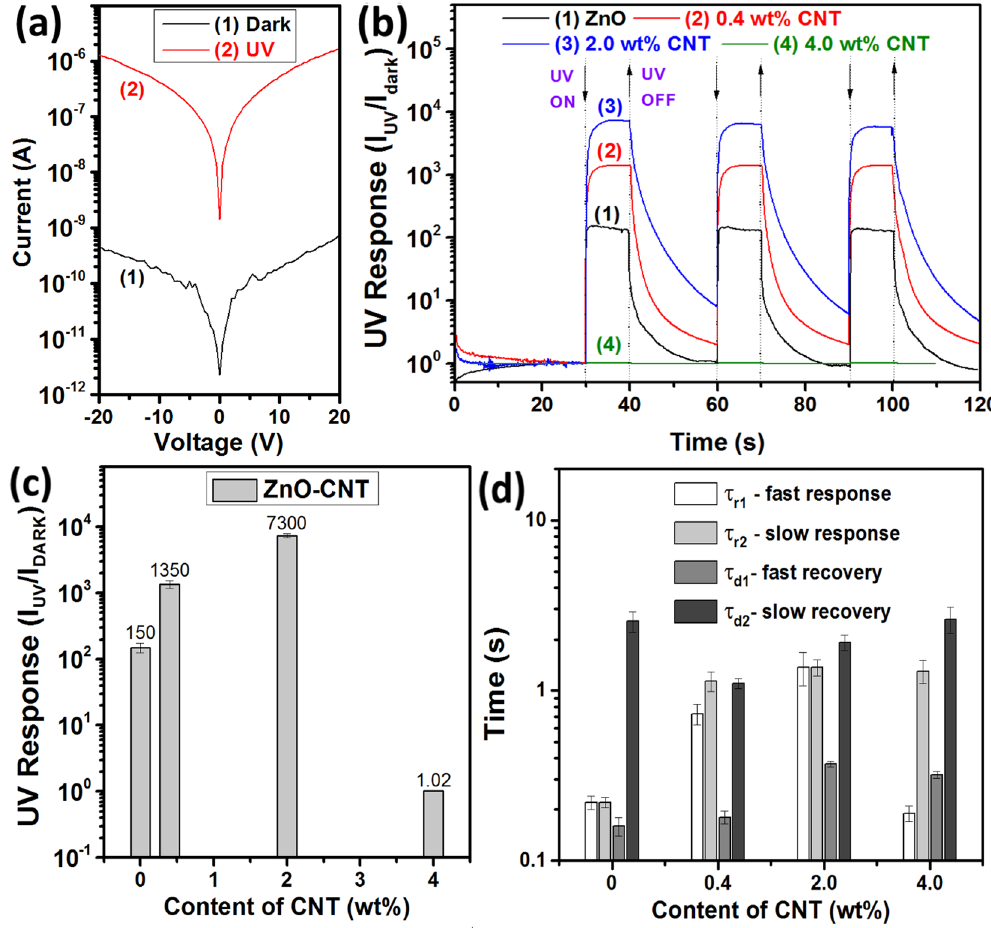
Figure 2. ( a ) Current – voltage characteristics of the device based on ZnO-CNT networks with 2.0 wt% CNT. ( b ) Dynamic UV response of ZnO-CNT networks with different content of CNT (C in wt%) at 10 V applied bias voltage. ( c ) UV response versus content of CNT in ZnO-CNT networks (C in wt%). ( d ) Calculated rise ( τ r1 and τ τ τ r2 ) and decay ( d1 and d2 ) time constants from UV response curves using bi-exponential